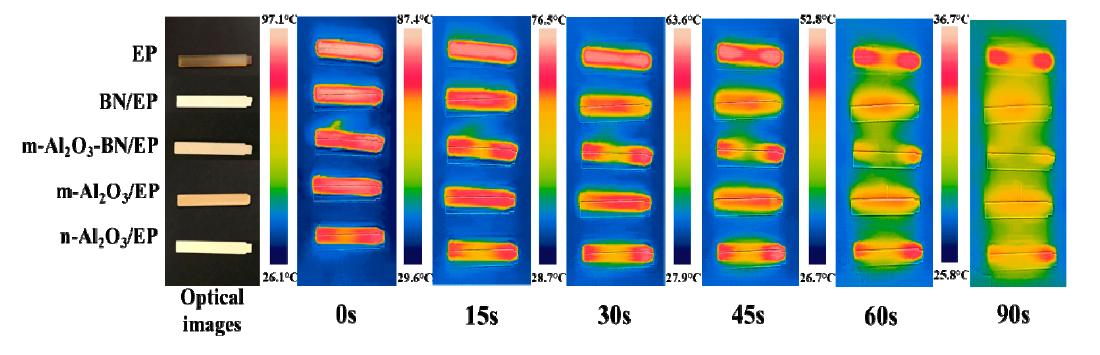
Figure 7. Optical and infrared thermal images of EP